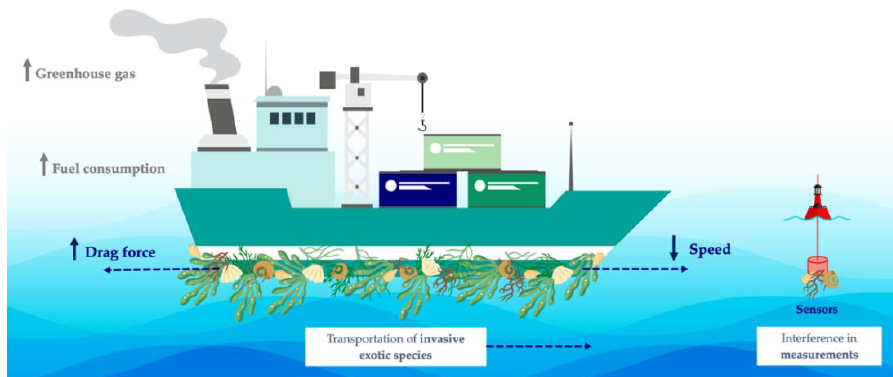
Figure 1. Schematic representation of the negative impact of marine biofouling.